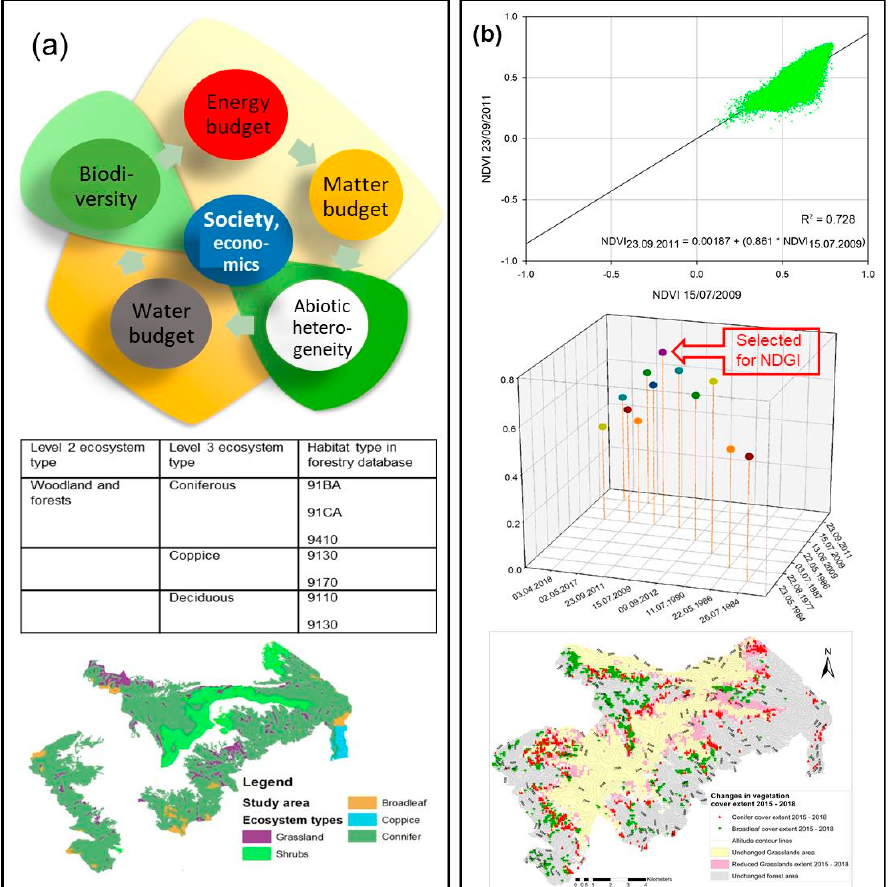
Figure 6. ( a ) Whole System approach: Conceptual view, data crosswalking and ecosystem type (level 2 or level 3) distribution on the ground; ( b ) Selection of pairs of satellite scenes by correlation analysis of NDVI between scenes; 3D graphic of the correlation coefficient values obtained via Pearson correlation analyses of NDVI between scenes, and georeferenced supplementary information on ecosystem types derived earlier and used for reference along with the results of vegetation change detection in Copernicus HRL